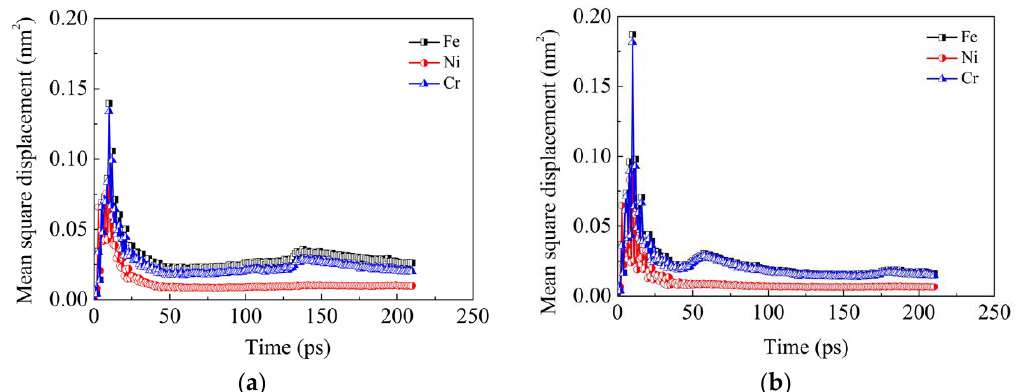
Figure 5. Mean square distance (MSD) results of Fe, Ni and Cr elements in the two models: ( a ) Model I; ( b ) Model ΙΙ.